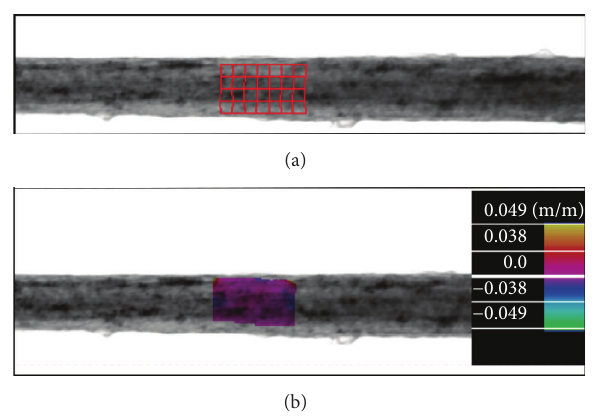
Figure 2: ROI selection. Example of a region of interest (ROI) superimposed on an X-MET surface (a) for longitudinal strain predictions